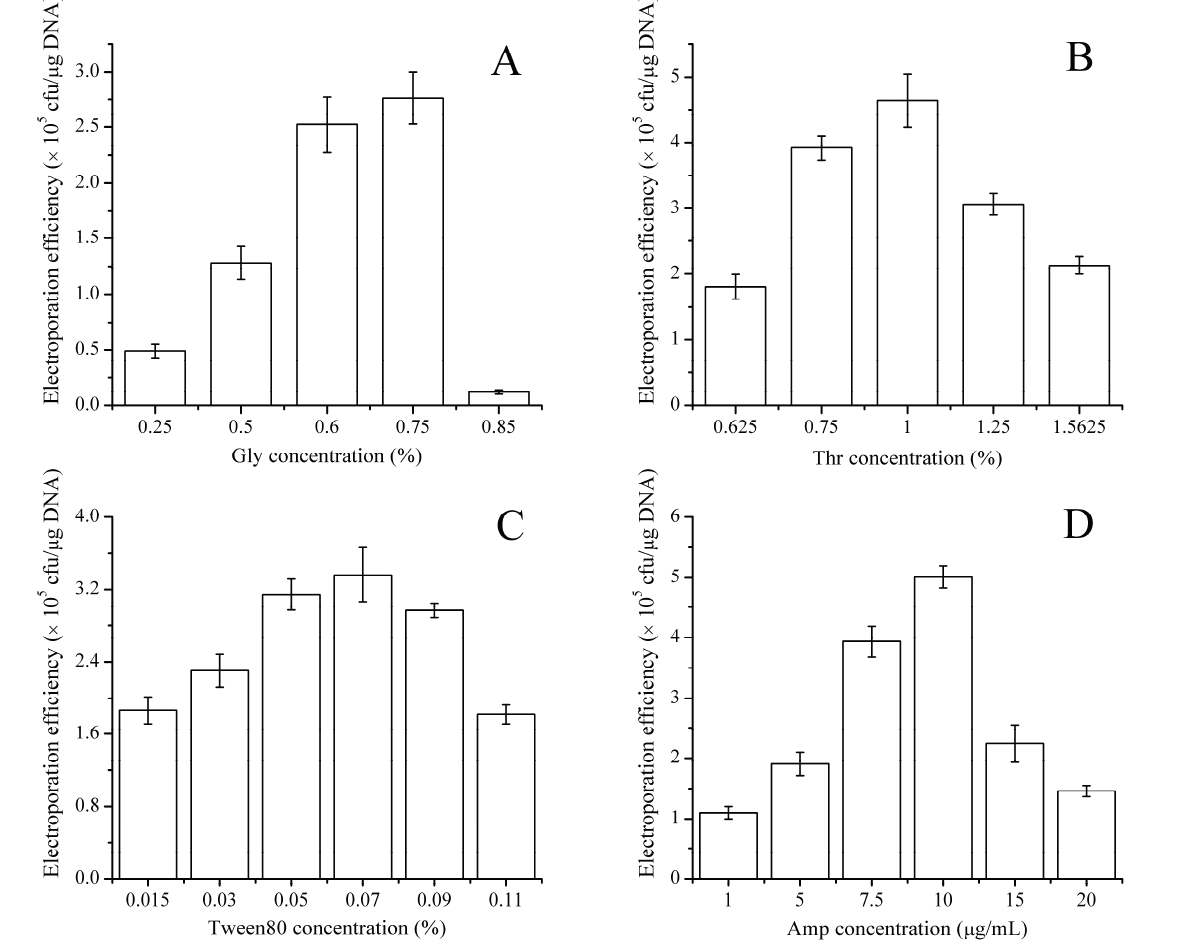
Figure 3. Effects of wall-weakening agents on the electroporation efficiency of B. subtilis ZK. Various weakening agents at different concentration gradients (0.25%–0.85% glycine ( A ); 0.63%–1.56% DL -threonine ( B ); 15–110 mg/mL Tween 80 ( C ) and 1–20 μ g/mL